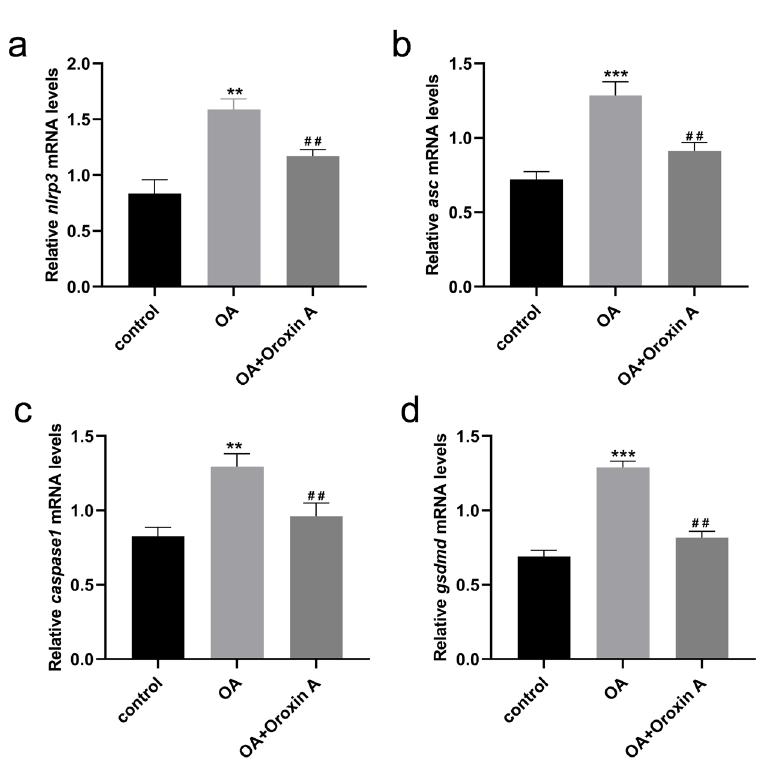
Figure 5. The effects of Oroxin A on pyroptosis-related mRNA expression in OA-induced A549 cell injury. The level of nlrp3, asc, caspase-1 and gsdmd in the OA group was significantly higher than that in the control group, but the level of nlrp3, asc, caspase-1 and gsdmd in OA+Oroxin A group was significantly lower than that in the OA group (a-d). All data were expressed as mean ± SEM. Statistical significance was analyzed by Student’s t test. ** p <0.01, *** p <0.001 compared with control group, ## p <0.01 compared with OA group, n=3 in each